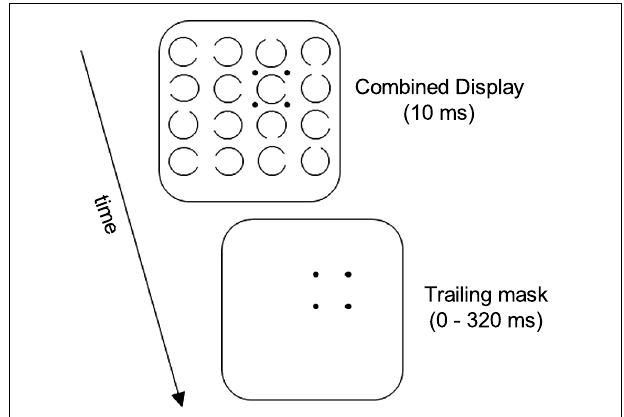
FIGURE 1 | Display sequence in a conventional OSM paradigm.